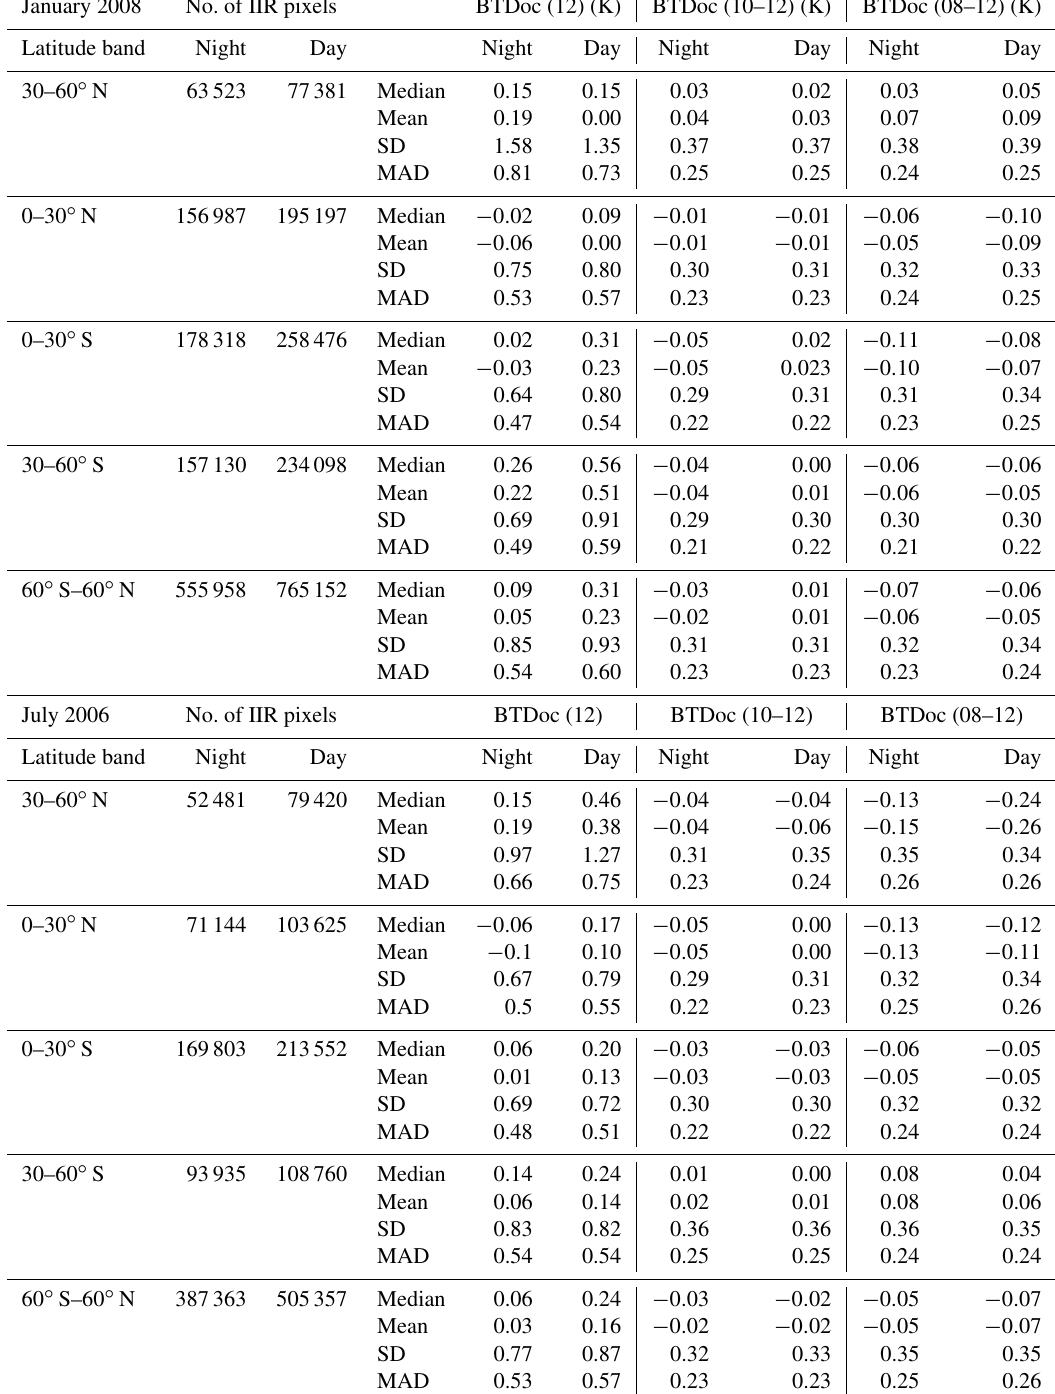
Table 2. V4 statistics (median, mean, standard deviation (SD), and mean absolute deviation (MAD)) of the differences between observed and computed brightness temperatures in V4 clear-sky conditions (no cleared clouds) over oceans in January 2008 and in July